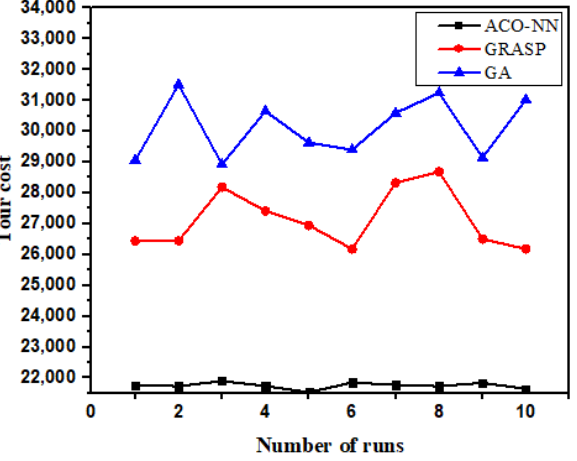
Figure 11. Results of optimal solutions vs. number of runs for